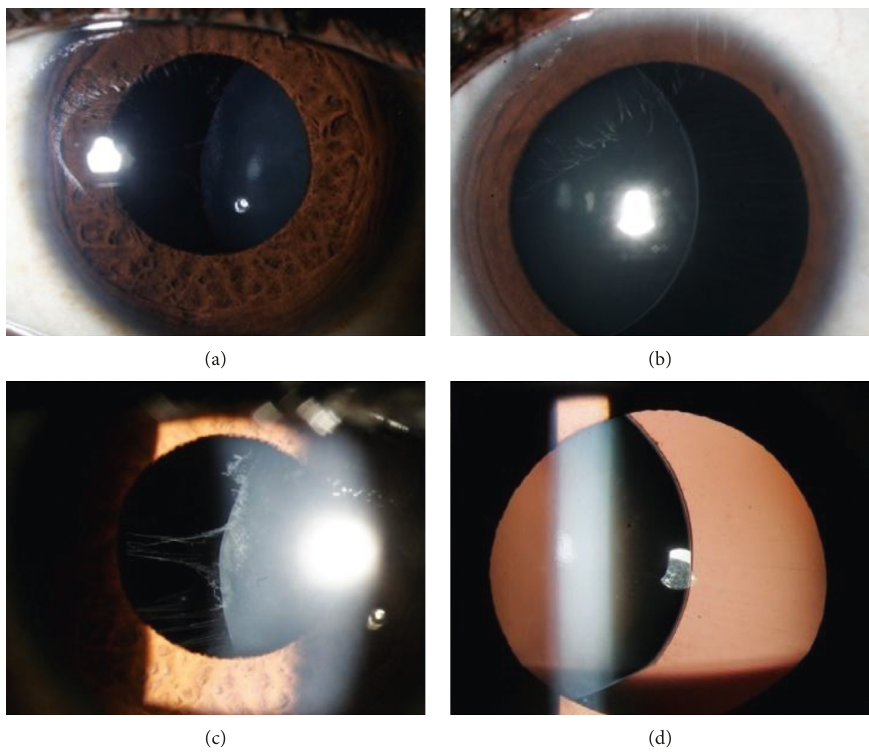
Figure 1: Preoperative images of patients with ectopia lentis. Table 1: Preoperative and postoperative uncorrected visual acuity (UCVA) and best-corrective visual acuity (BCVA) of the patients. Preoperative Postoperative